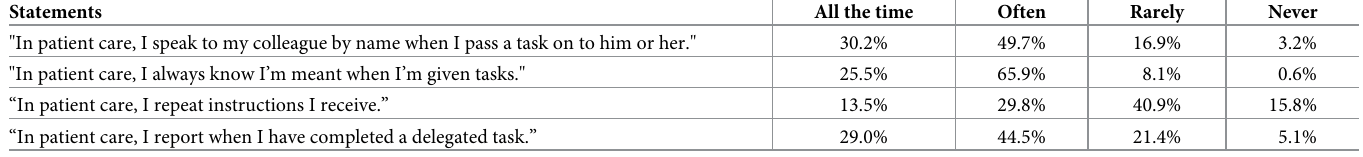
Table 3. Components of a closed-loop